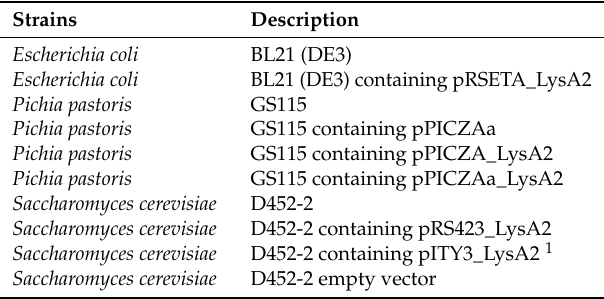
Table 1. Bacterial and yeast host strains used in this